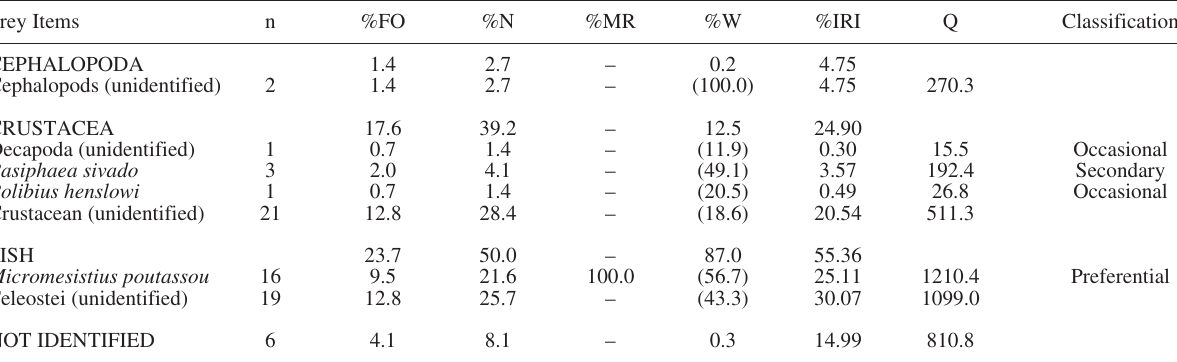
Table 4. – List of identified prey categories in the diet of Etmopterus pusillus caught by longlines (number of individuals with food in their stomachs=148). GE: ecological group (D: demersal, M: mesopelagic, P: pelagic, B: benthic, Na: not attributable); n: number of prey; %FO: frequency of occurrence; %N: percentage in number; %MR: percentage by reconstructed mass %W: percentage by dry weight (estimated mass within each component is in parentheses); %IRI: index of relative importance; Q: food coefficient; and prey classification. Prey